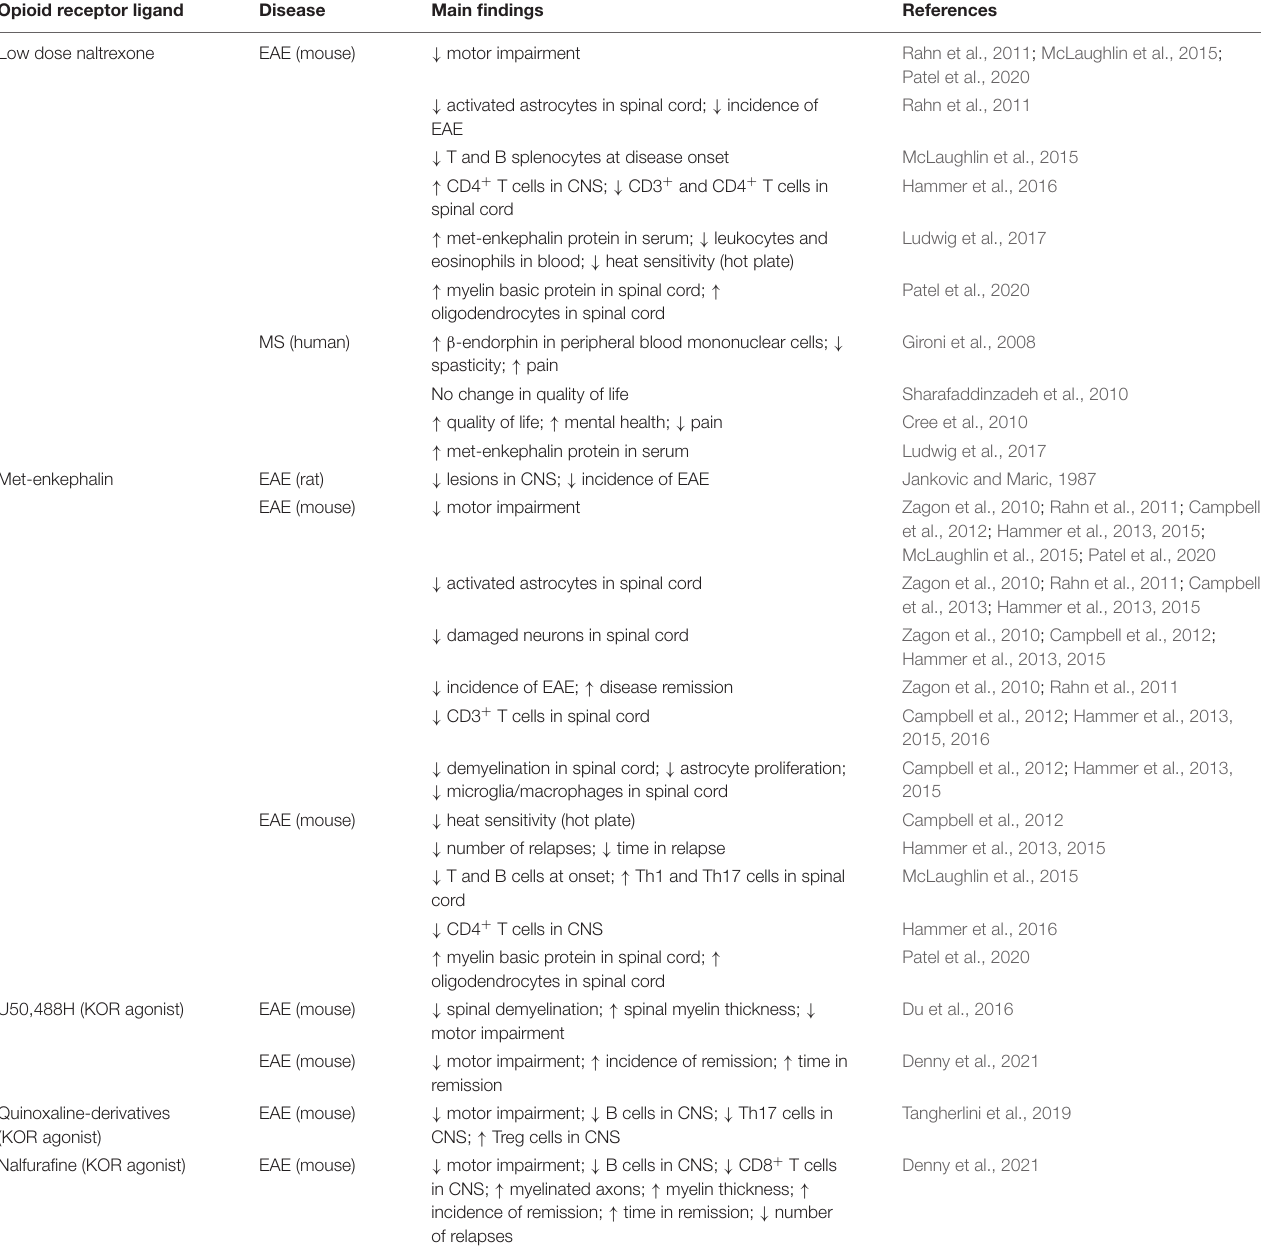
TABLE 2 | Effects of exogenous opioid treatment in MS patients and animal